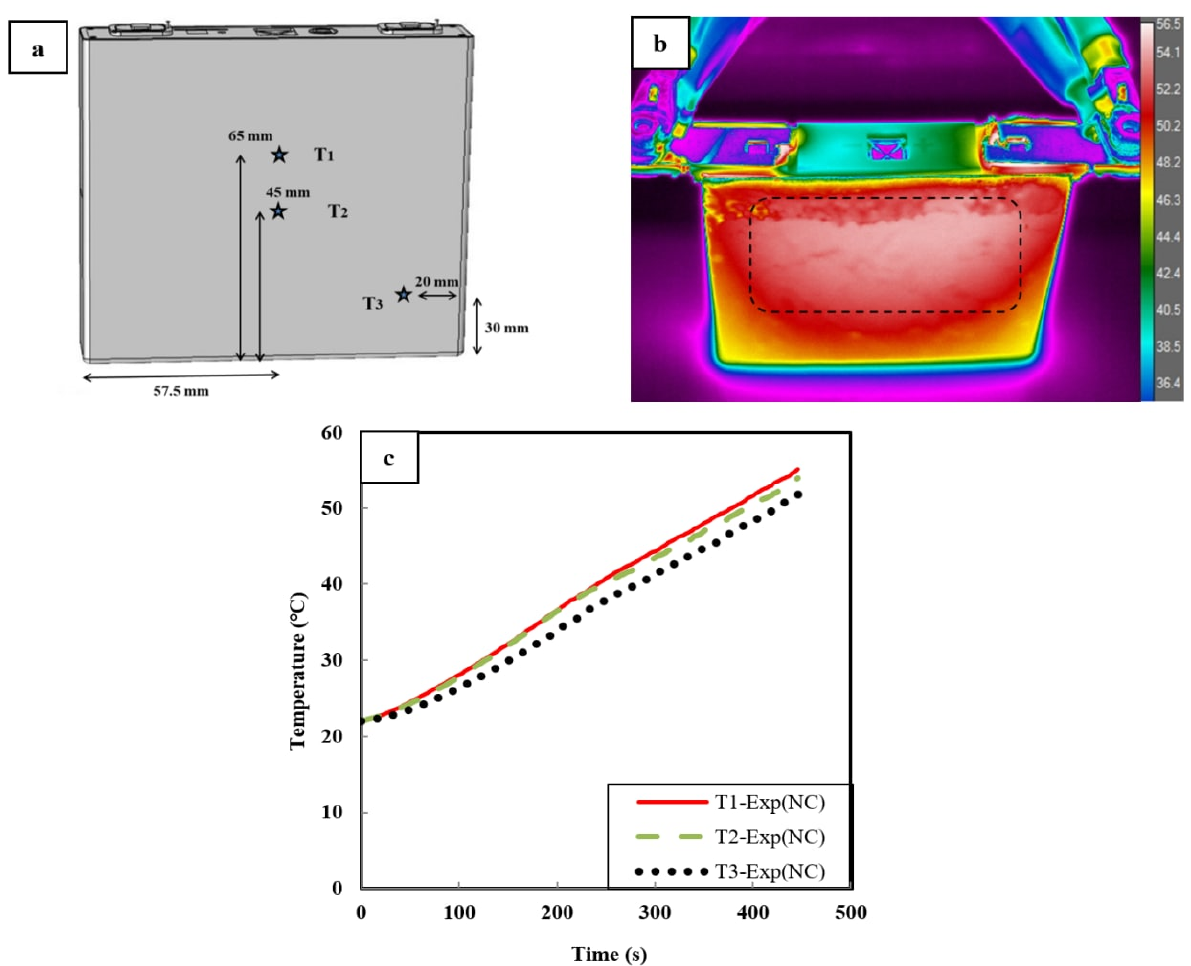
Figure 19. ( a ) The LTO battery with the position of the K-type thermocouples; ( b ) the thermal image picture; ( c ) temperature evolution under 8C discharge rate [91].